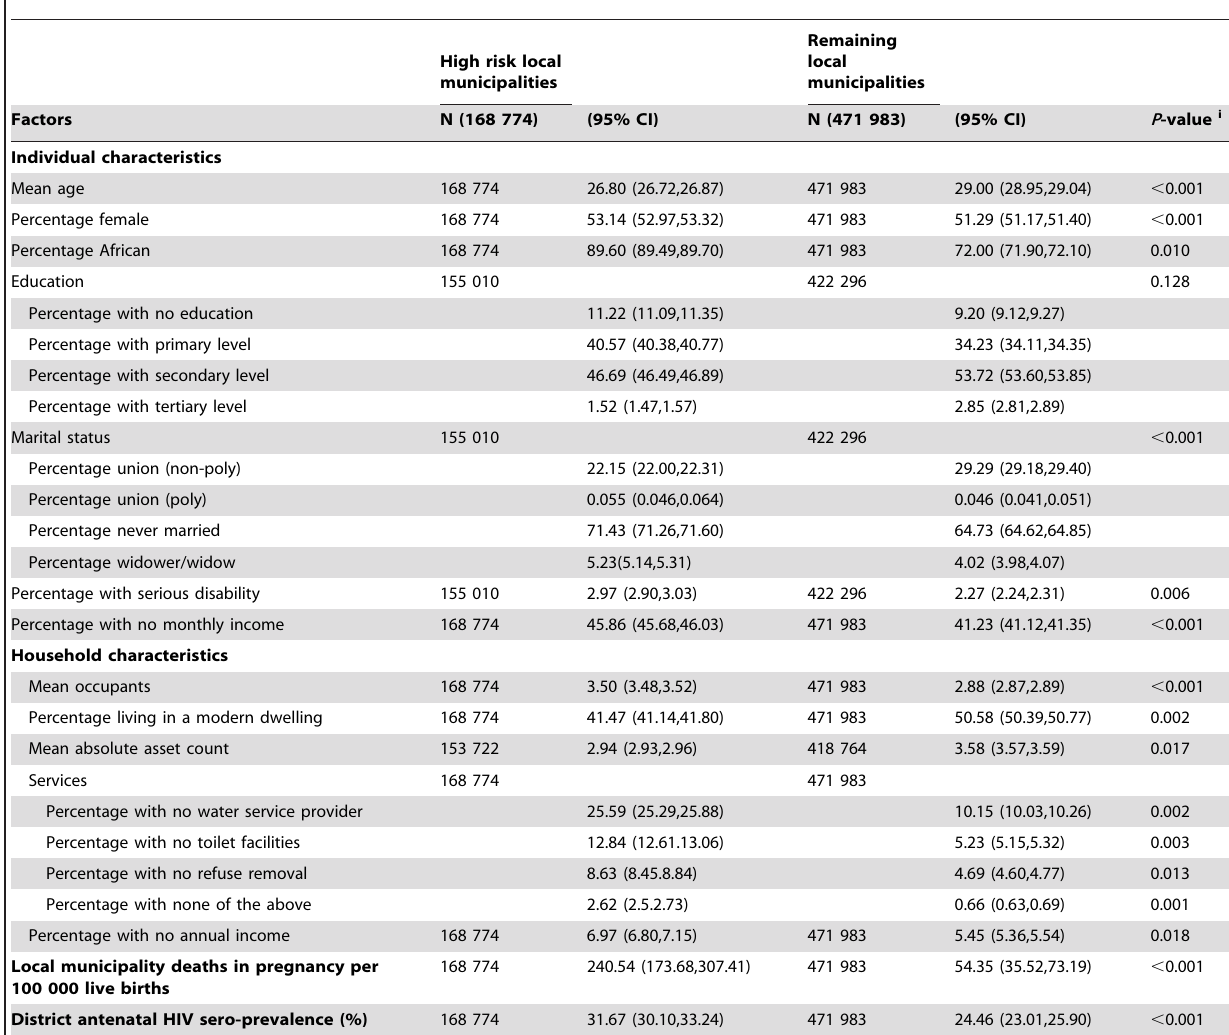
Table 2. Bivariate multilevel determinants for high risk adult mortality areas using an ecological framework, South Africa, 2007.